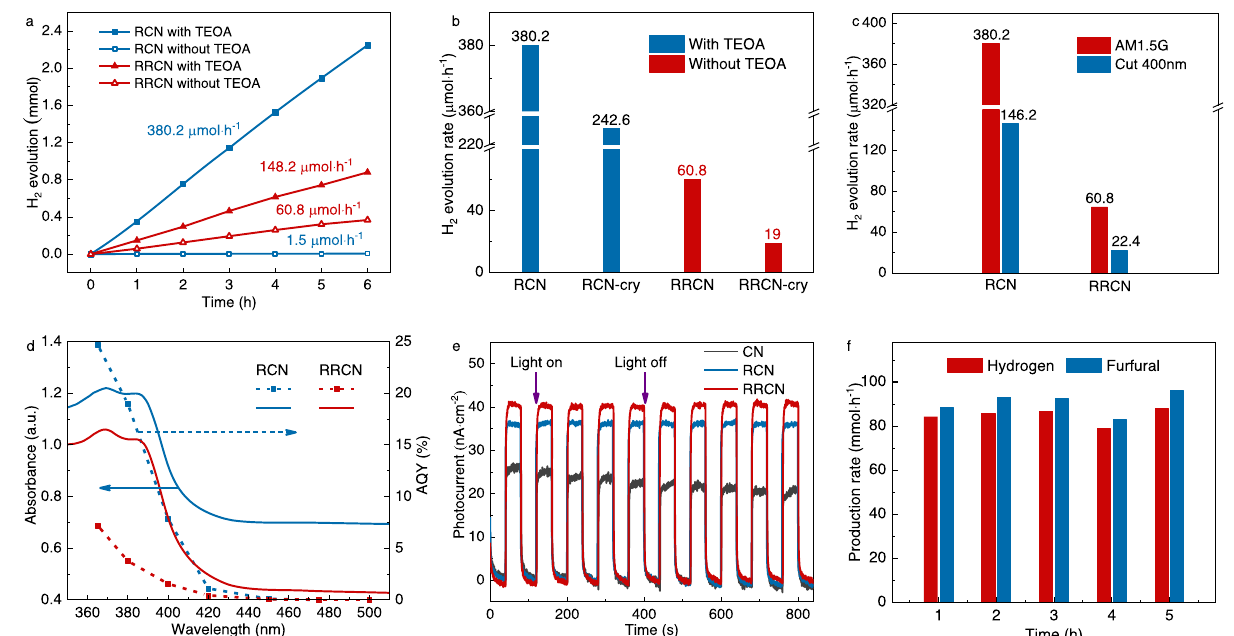
Fig. 5 | Catalytic performance of RCN and RRCN. a Typical time course of H 2 productions under light irradiation ( λ ≥ 350nm) for CN, RCN (left, with 15 vol % TEOA as sacri fi cial agent), and RRCN (right, without sacri fi cial agent). b Comparative presentation of the H 2 evolution rates. c Photocatalytic H 2 evolu- tion activities undersimulated sunlight ( λ ≥ 350nm) and visible( λ ≥ 400nm) light